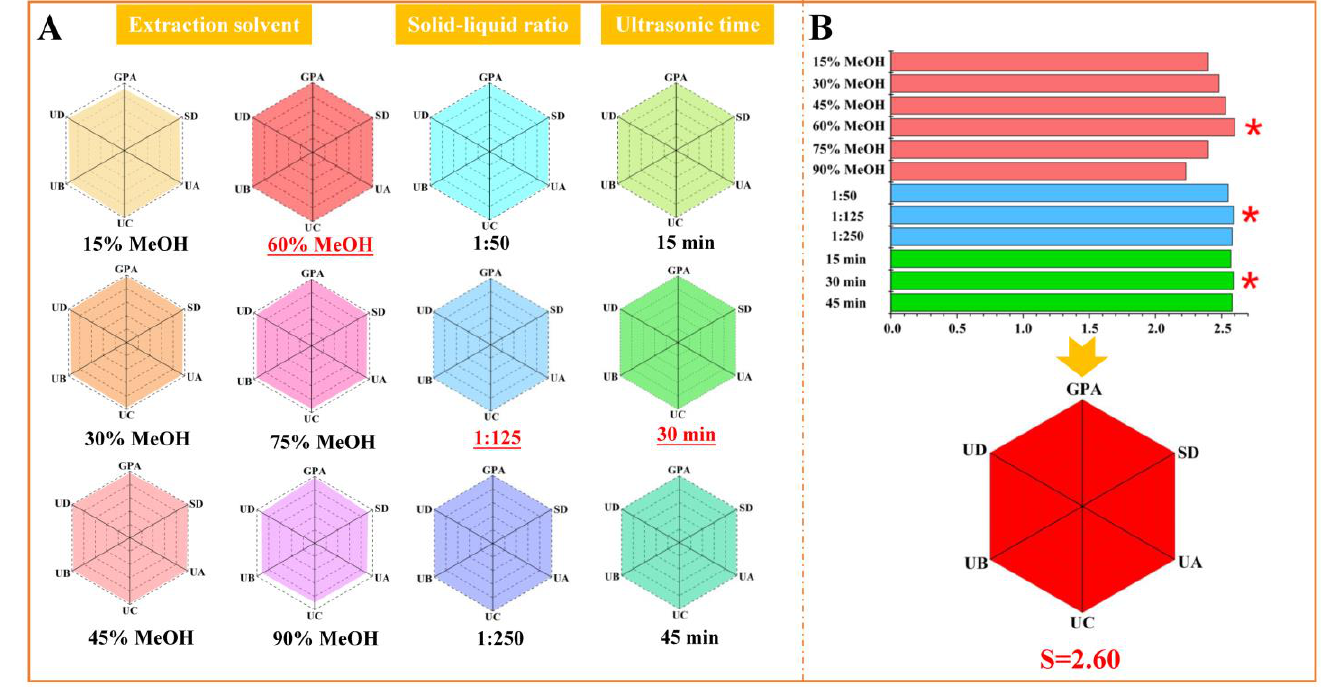
Figure 2. Optimization of the extracting method for seed meal of E. ulmoides Oliv. using the “spider- web” mode, including extraction solvent, solid-liquid ratio, and ultrasonic time. * The optimal values.